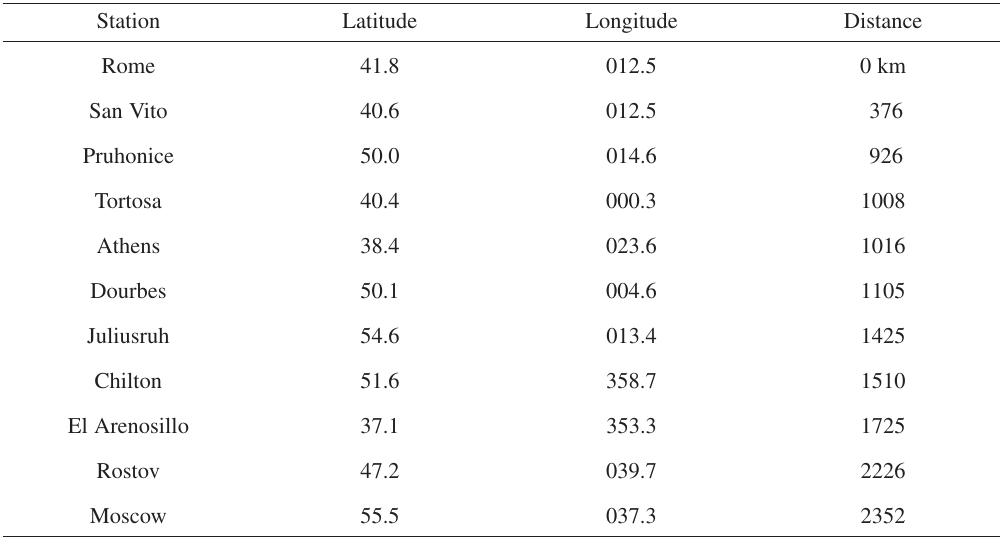
Table I. Geodetic coordinates and the distance between Rome and other stations used for the correlation study.